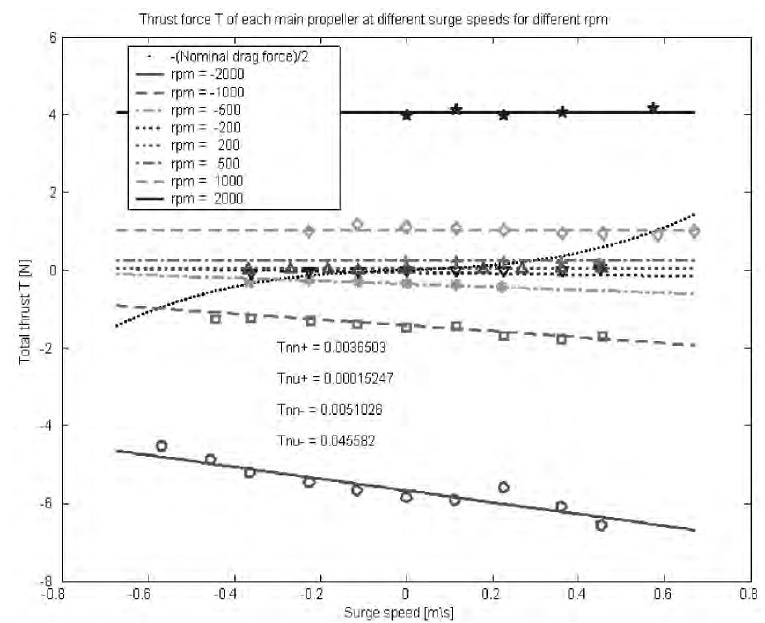
ó T for di ff erent propeller revolutions 1 2